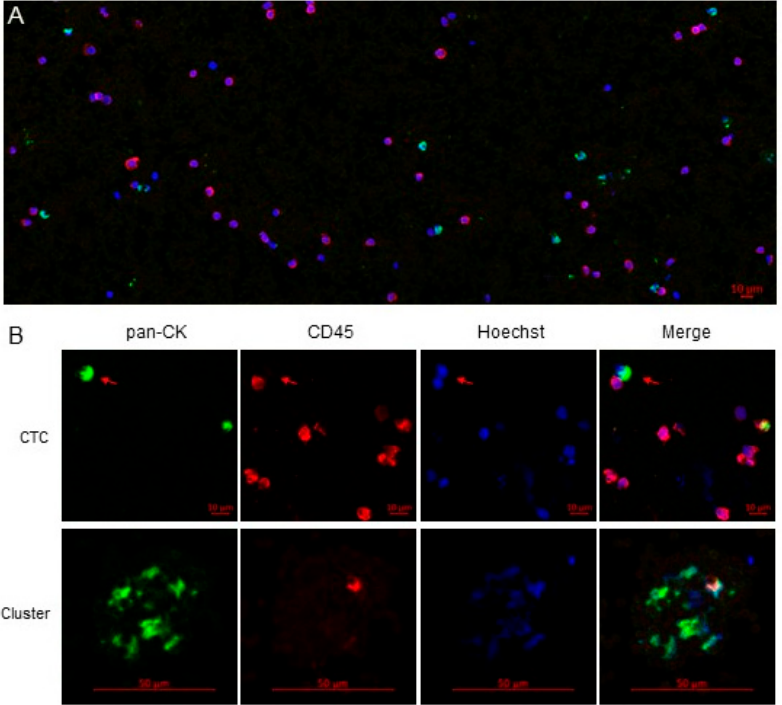
Figure 3. Analyses of CTCs isolated by the IsoFlux TM System. ( A ) Fragment of a typical image obtained by confocal microscopy after scanning a sample stained with anti-human pan-CK and anti-human CD45 antibodies. Hoechst 33,342 was used to stain the cell nuclei. ( B ) Representative images of a typical CTC (nucleated, EpCAM + /CK + /CD45 − ) and a CTC cluster. Magnetic beads coated with anti-EpCAM used for CTCs enrichment can also be observed.